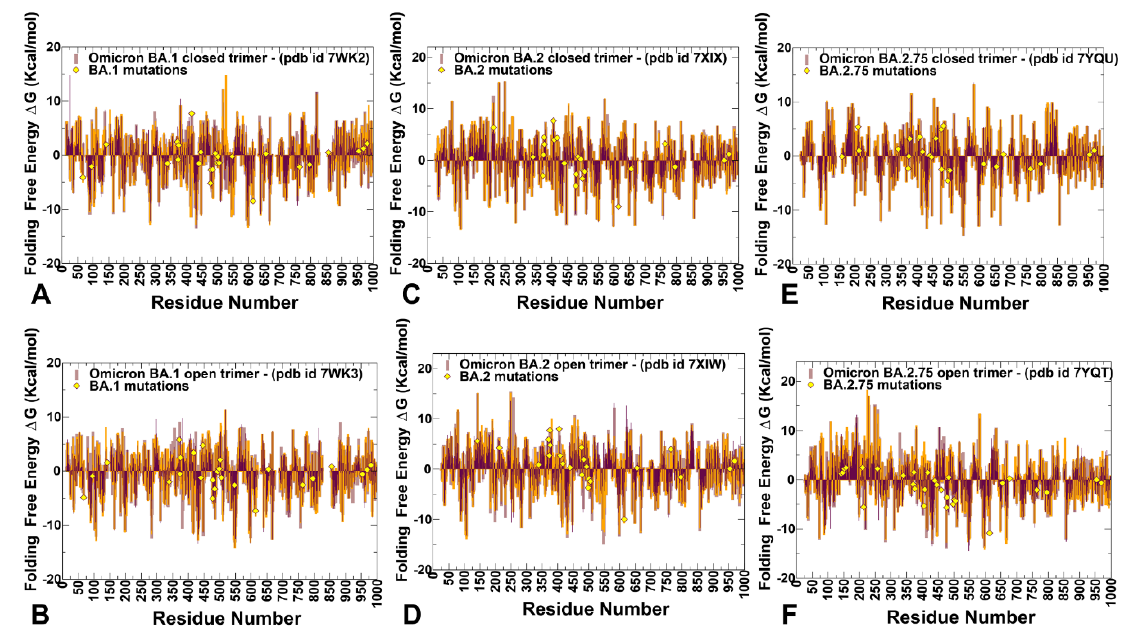
Omicron trimer (pdb id 7WK3). The three protomers A,B,C of the S Omicron trimers are shown in green, red and blue ribbons respectively. The Omicron mutational sites G339D, S371L, S373P, S375F, K417N, N440K, G446S, S477N, T478K, E484A, Q493R, G496S, Q498R, N501Y, Y505H, T547K, D614G, H655Y, N679K, P681H, N764K, D796Y, N856K, Q954H, N969K, and L981F are shown in spheres for all protomers and colored according to the protomer identity. ( B ) The structural mapping of the protein stability hotspots for the open BA.1 trimer, pdb id 7WK3 (Supplementary Materials Figure S2). The stability hotpots are shown in spheres colored according to the protomer identity.